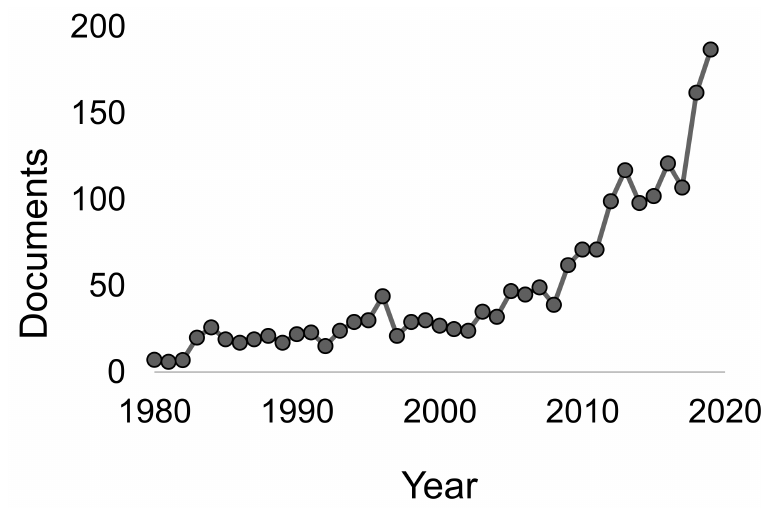
Figure 1. Publishing trends (number of papers) in the area of phosphogypsum research (using Scopus